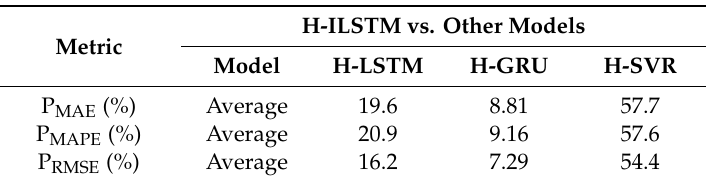
Table 8. The promoting percentages of the other models by the H-ILSTM model of one-step prediction for the load datasets 1–4.